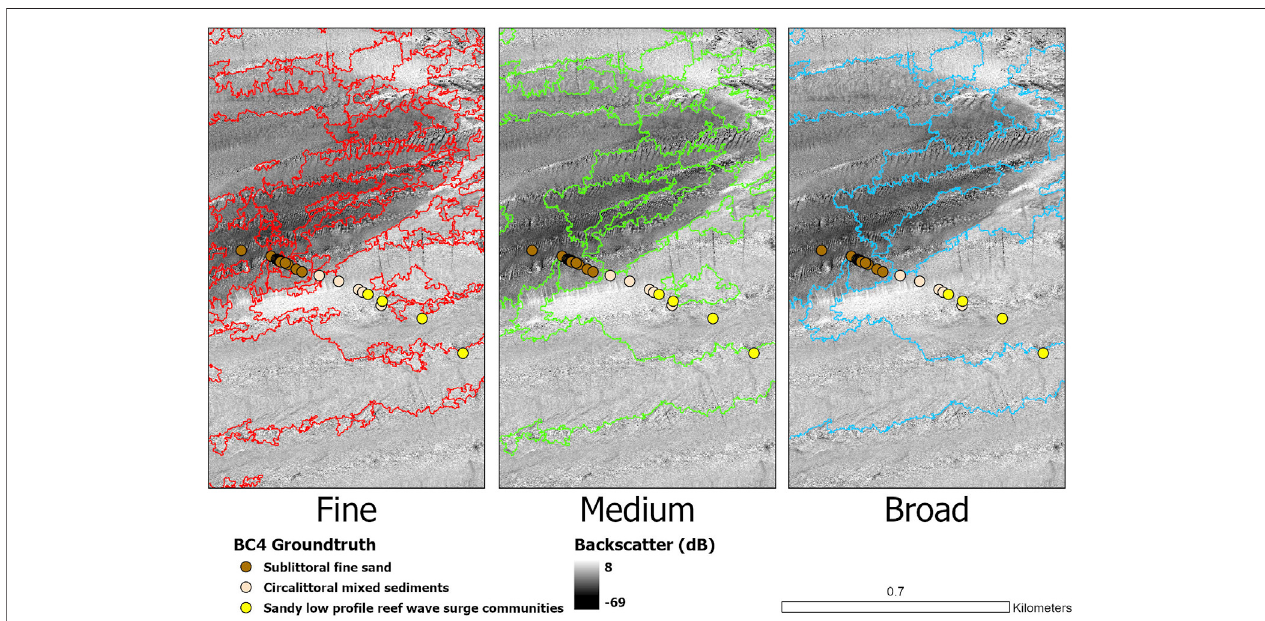
FIGURE 4 | Image segmentation examples showing differences between fi ne (4,531) medium (2,486) and broad (1,608) over the backscatter mosaic. The CBiCS classi fi cationfrom thebiotopecomplex(BC4) classi fi cation isalso included ascategorizedpointstoshowhowthedifferentbackscatterintensitiesre fl ectthedifferences in those classes over sediment habitats.